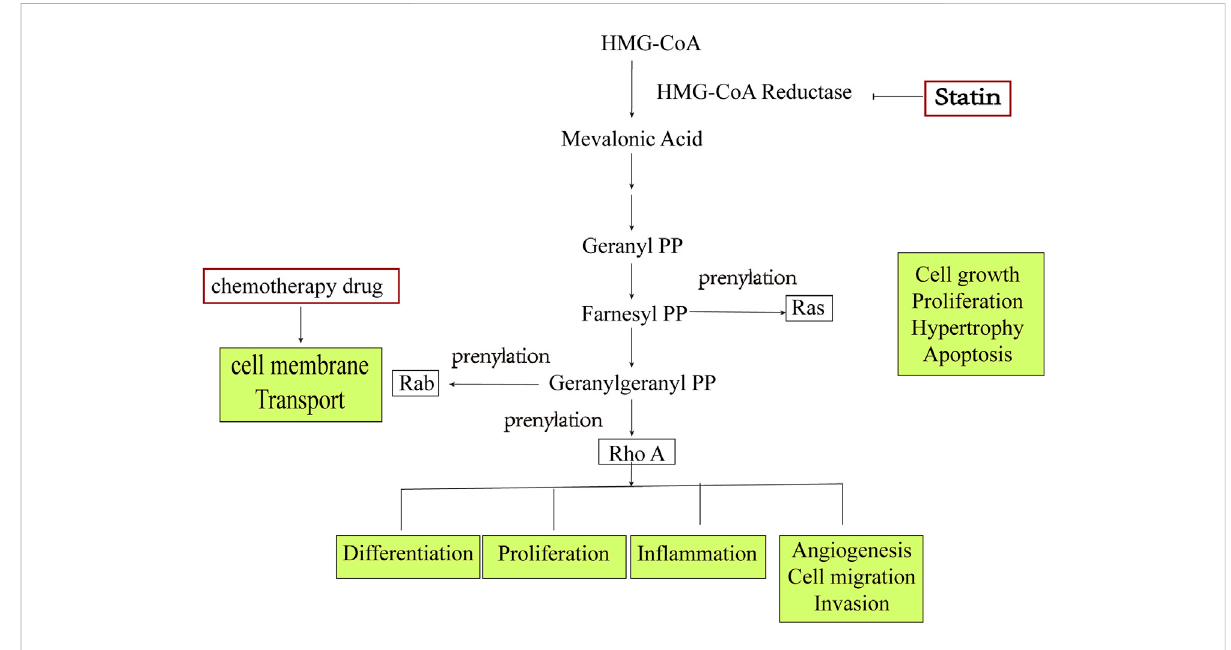
FIGURE 2 Effect of statins on small GTPase and its potential antitumor